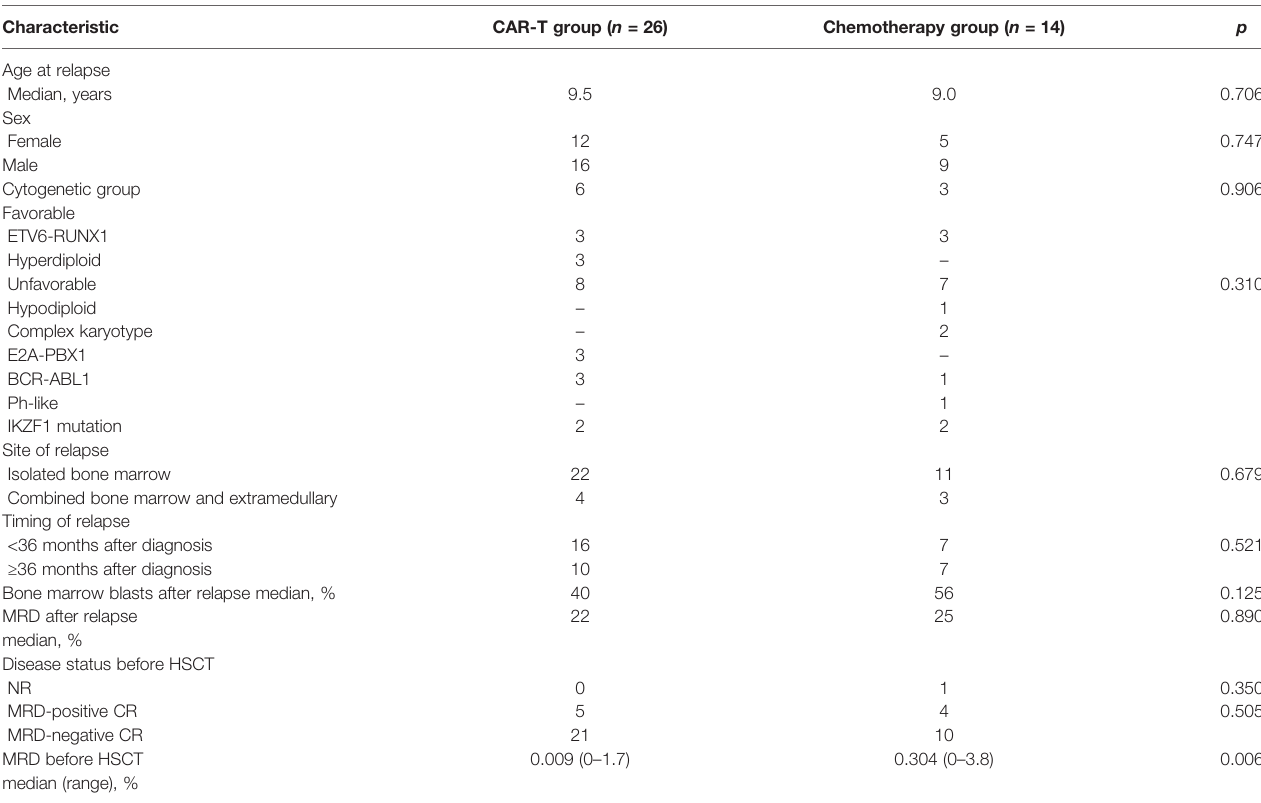
TABLE 1 | Characteristics of patients strati fi ed by CAR-T and chemotherapy groups.